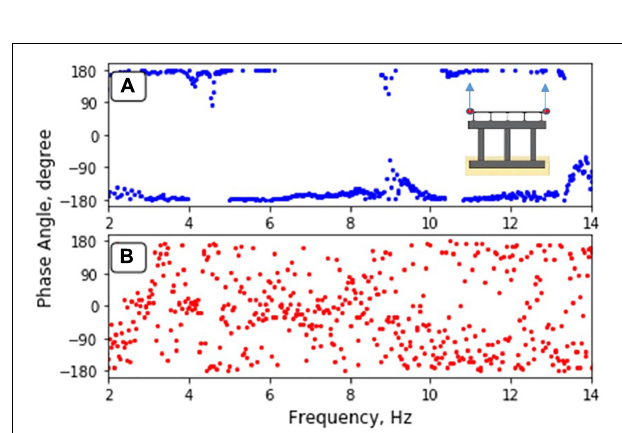
FIGURE 12 | Phase angles between the vertical response of the east and west sides of the bridge deck under (A) lateral transverse loading from T-Rex and (B) ambient